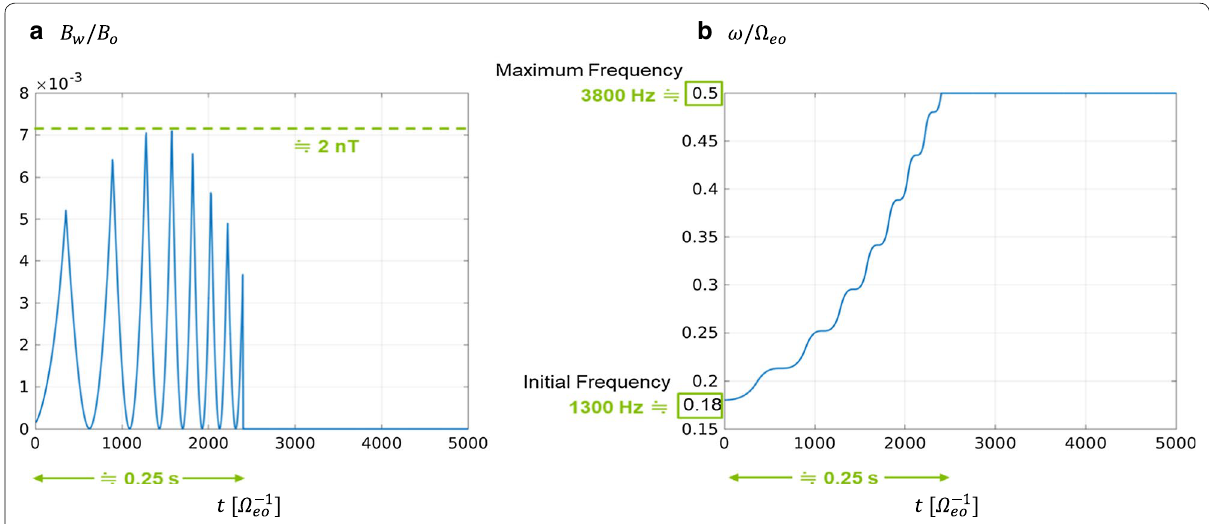
Fig. 2 The equatorial simulation wave model of amplitude B w and frequency ω . a Multi-subpacket chorus wave amplitude B w normalized by the external dipole magnetic field at the equator B 0 . The model comprises eight subpackets with the largest peak value of about 2 nT over 0.25 s under assumption of B 0 as 270 nT and Ω e 0 as 7.6 kHz. b Multi-subpacket chorus wave frequency ω normalized by Ω e 0 rising from 1.3 to 3.8 kHz